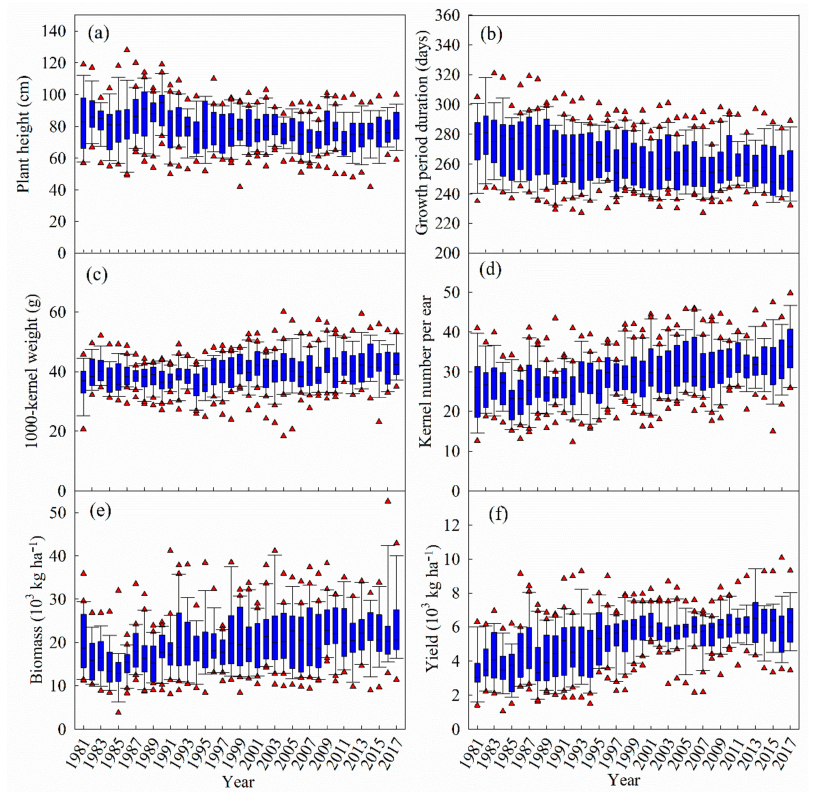
Figure 4. The box plots of the growth- and yield-related parameters of winter wheat over 1981–2017 at the 20 sites of Xinjiang, China. ( a ) Plant height of maturity stage, ( b ) growth period duration, ( c ) 1000-kernel weight, ( d ) kernel number per ear, ( e ) biomass of maturity period, and ( f )